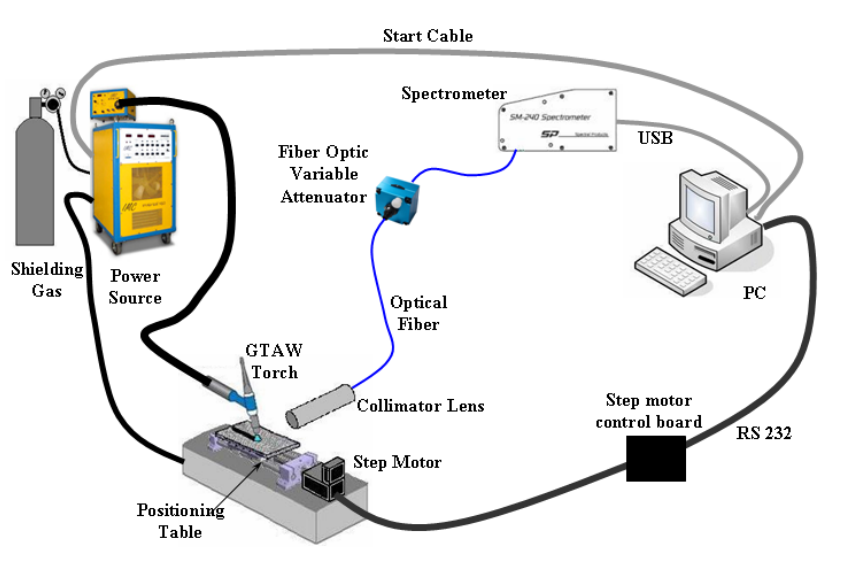
Figure 3. Experimental